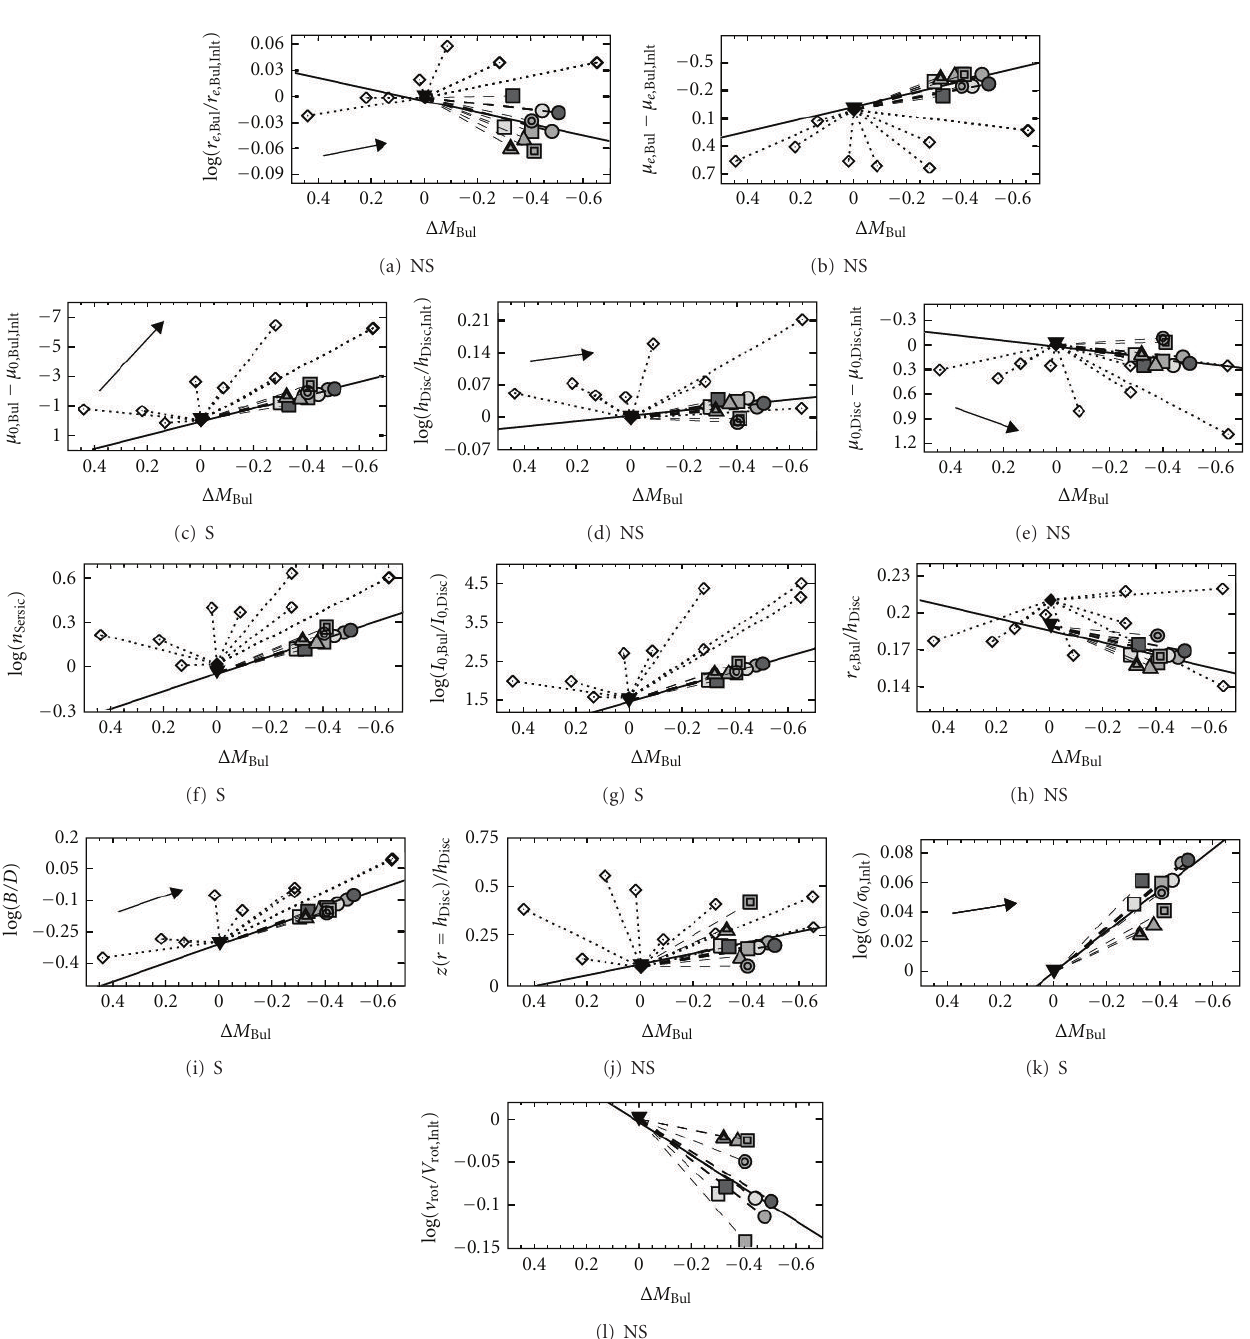
Figure 19: The dependence of bulge and disc parameters, and B/D ratio, on the increment of the bulge magnitude (see details in [250]).